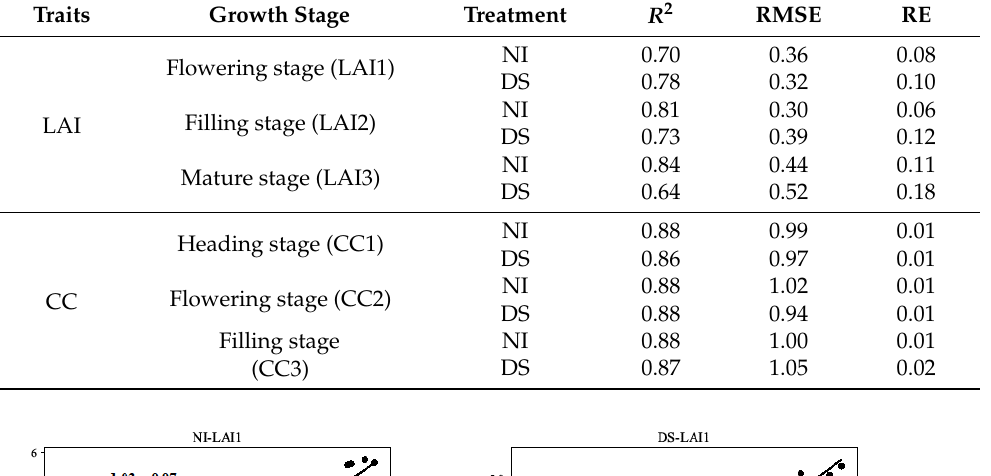
Table 2. Determination coefficient ( R 2 ), root-mean-square error (RMSE), and relative error (RE) of the algorithm for modeling the estimation of leaf area index (LAI) and chlorophyll content (CC) of wheat at different growth stages under normal irrigation (NI) and drought stress (DS) conditions.